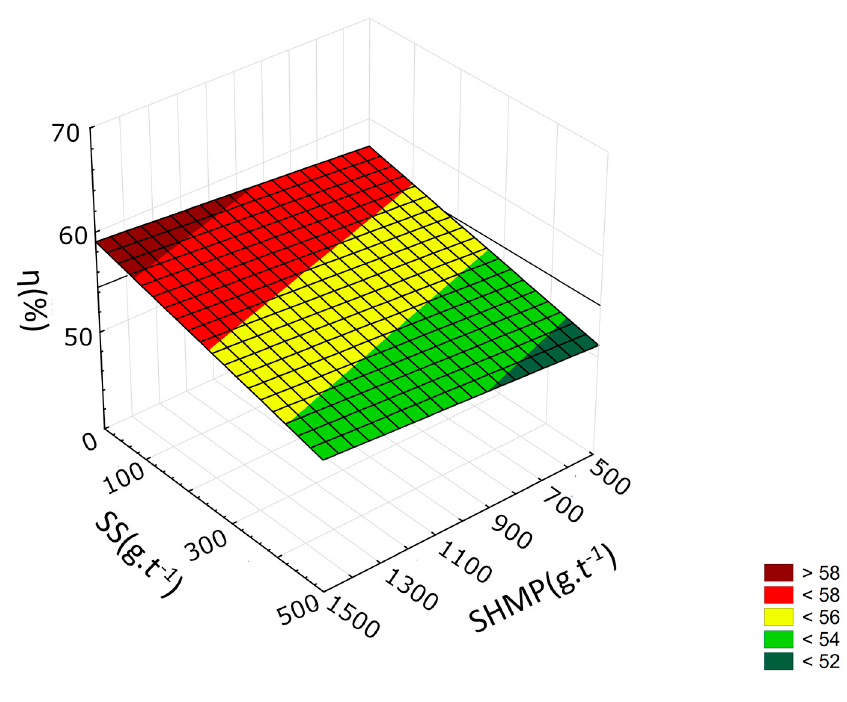
Figure 3. ( a ) (50 g.t − 1 MIBC), ( b ) (80 g.t − 1 MIBC), ( c ): Response surfaces representing the effect of SHMP and SS on the recovery of talc to froth product at different dosages of MIBC frother. The thick black lines represent the recovery of talc achieved using frother as the only